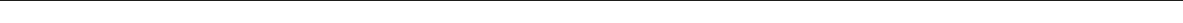
Fig. 4 Isolation of macrophage-derived fi broblast-like cells from wound-derived explants. a Primary dermal fi broblasts isolated from skin or d10 post- wounding tissue of LysM Cre Rosa mT/mG mice. Scale bar = 50 µ m. b GFP + FSP + fi broblasts interlinked with GFP − FSP + fi broblast isolated from d10 wound explants. Scale bar = 20 µ m. c (left) Immunostaining of GFP + (myeloid, green) and FSP1 ( fi broblast, blue) cells in d10 wound explants skin cultures n = 5, scale bar = 50 µ m. Colocalization of the GFP + cells (green) with FSP1 + (blue) demonstrating their myeloid origin. (right) Immunostaining of GFP + (myeloid, green) and Col1 ( fi broblast, blue) cells in d10 wound explants skin cultures n = 5, scale bar = 50 µ m. Multiple fi broblast-speci fi c staining (FSP1/ Col1) demonstrated the purity (>99%, fi broblasts) of the explant culture. d Heat map illustrating clusters of transcripts from GFP − CD90 + or GFP + CD90 + primary fi broblasts isolated from d10 wound explants. Additionally, GFP - CD90 + primary fi broblast were isolated from unwounded skin. Gene expression pro fi ling of 70 genes relating to ECM/ fi broblast was performed using NanoString nCounter system. The expression pattern of GFP − CD90 + or GFP + CD90 + primary fi broblasts from d10 wound explants were largely similar, i.e., not signi fi cantly different ( t -test with Bonferroni correction) but was distinctly different from unwounded skin GFP - CD90 + primary fi